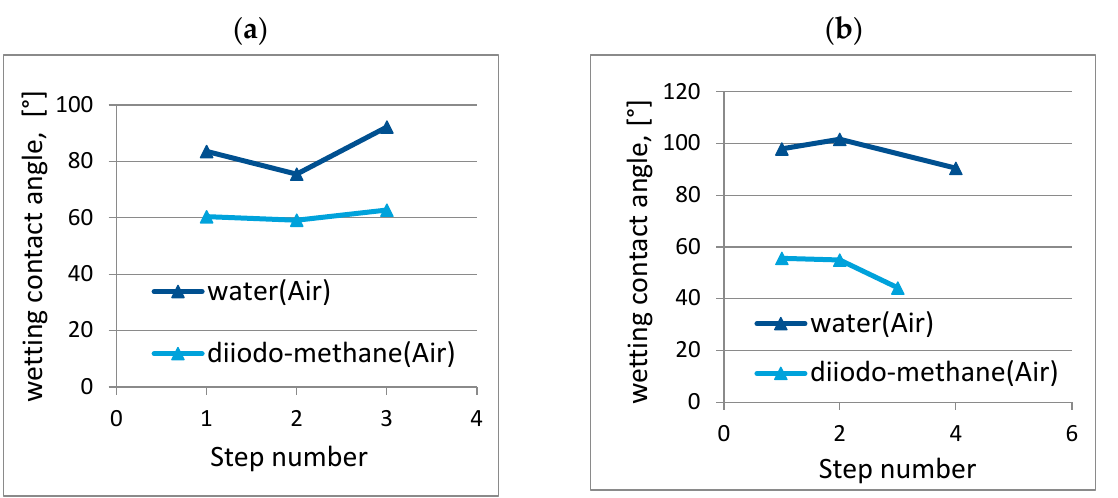
Figure 13. We tt ing contact angle of pure epoxy sample without fi ller ( a ) and composite containing Figure 13. Wetting contact angle of pure epoxy sample without filler ( a ) and composite containing 30 wt.% . wheat straw ( b ). 30 wt.%. wheat straw ( b ).